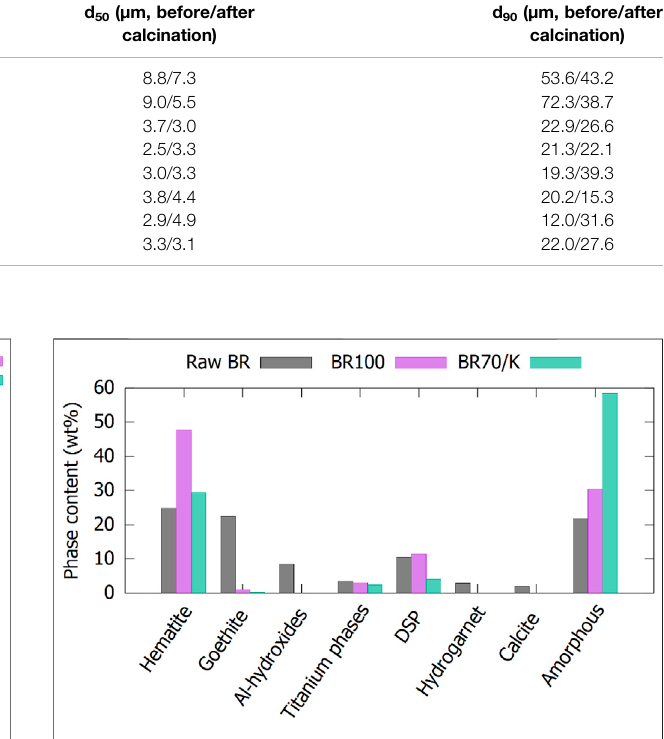
FIGURE 1 | Quanti fi cation of the major phases in the raw BRs. *the quantity of DSP and hydrogarnet also takes into account the calculated amount of nano-crystalline DSP and hydrogarnet.